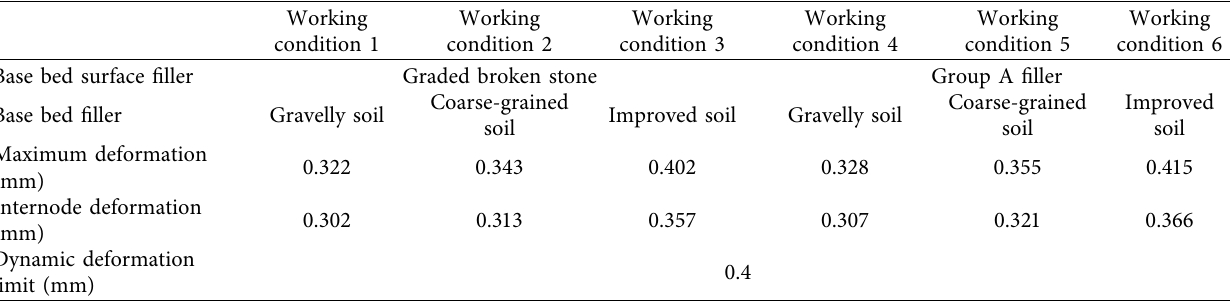
Figure 14: Deformation distributioncurve of the surface layer ofthe subgrade: (a) distributed along the X -axis (longitudinal); (b) distributed along the Y -axis Table 5: Reasonable thickness of different bed fillers.